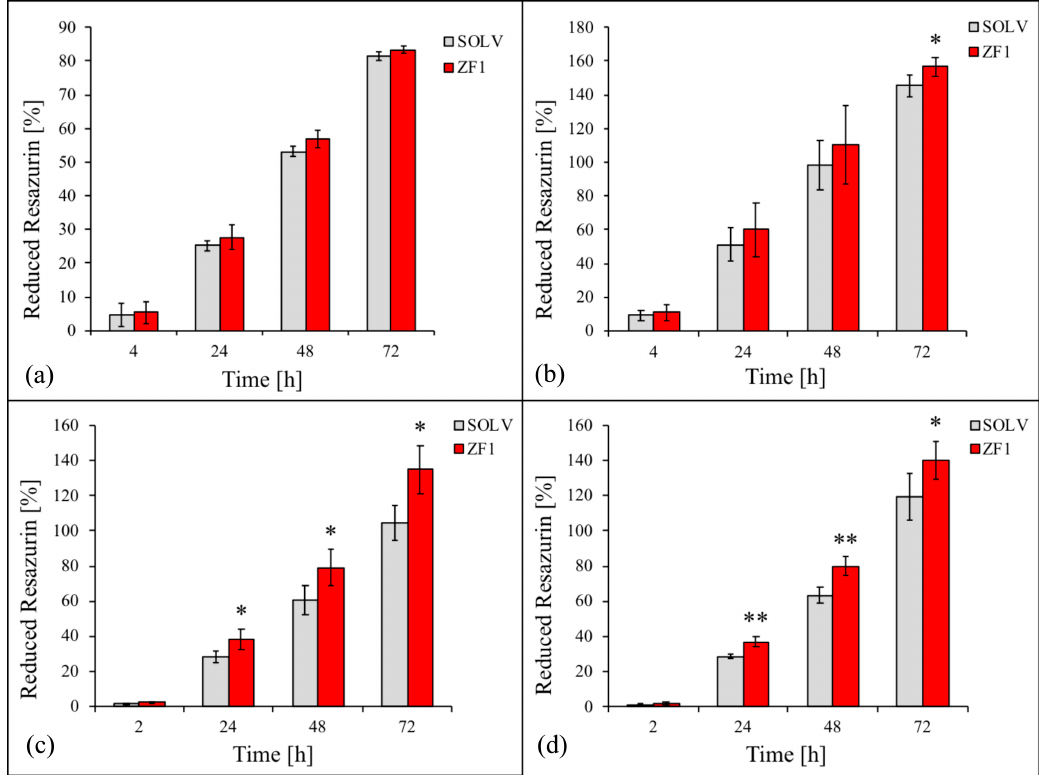
Figure 7. The effects of different concentrations of ZF1 on metabolic activity in hMSCs. The hASCs ( a ), hBM-MSCs ( b ), hDP-MSCs ( c ) and hWJ-MSCs ( d ), at passages 5th–7th, were exposed for 72 h in the